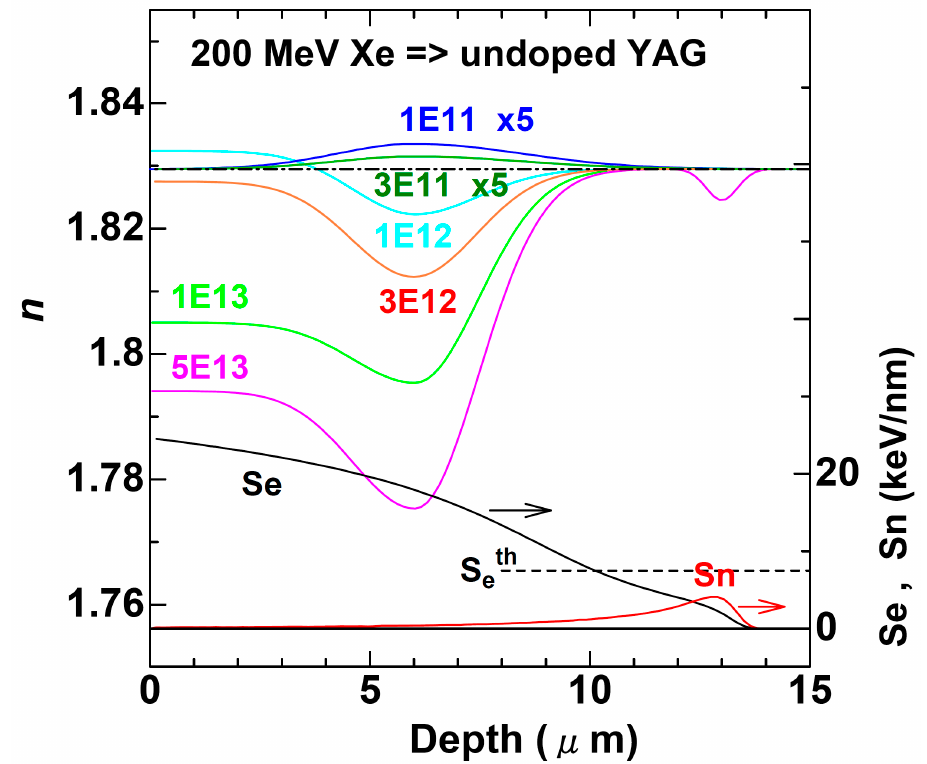
Figure 5. Depth profiles of refractive indices of YAG irradiated with 200 MeV Xe 14 + ions to various fluences ranging from 1 × 10 11 ions / cm 2 to 5 × 10 13 ions / cm 2 , determined by the prism coupling and the end-face coupling method. All the polarizations are in the transverse magnetic (TM) configuration. A chained horizontal line indicates the index in the unirradiated state of 1.8295 at the wavelength of 632.8 nm from literature. Since the deviation from the unirradiated value was so small for the data of 1 × 10 11 and 3 × 10 11 ions / cm 2 , the deviations were 5 times multiplied and added to the unirradiated value. For references, the depth profiles of electronic and nuclear stopping powers S e and S n are plotted with the right axis in the units of keV / nm. A horizontal broken line denotes the threshold S e value for the track formation in YAG.